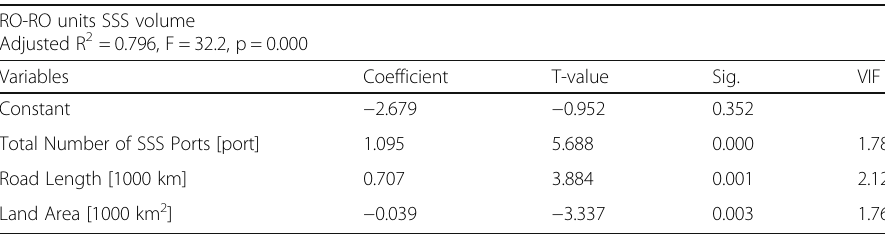
Table 7 RO-RO units SSS